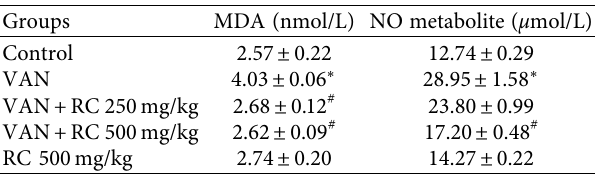
tSH, total thiol content; PCO, protein carbonyl; NO, nitric oxide metabolites; MDA, malondialdehyde; VAN, vancomycin; RC, Rosa canina . Each value represents the mean ± SEM. ∗ Statistically significant compared to the control group ( P < 0 . 05); # statistically significant compared to the VAN group ( P < 0 . 05). Table 2: Effect of RC extract on oxidative stress markers in VAN- treated rat